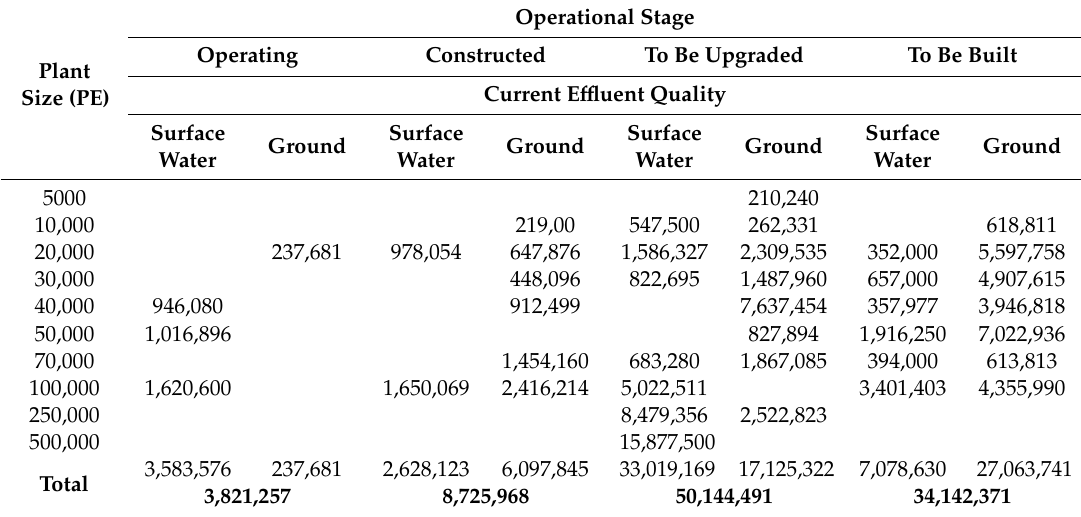
Table 5. Technically recoverable annual volumes (m 3 ) of reclaimed urban wastewater for irrigation in Puglia (2015).